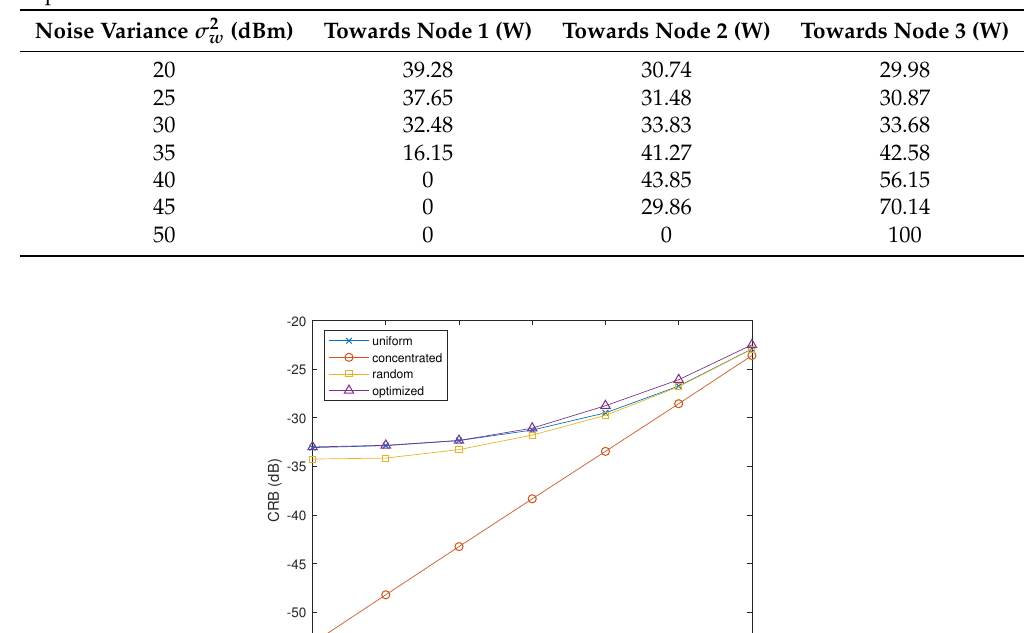
Table 1. Optimized interference power towards 3 radar nodes versus noise variances in the first experiment of Scenario 1.